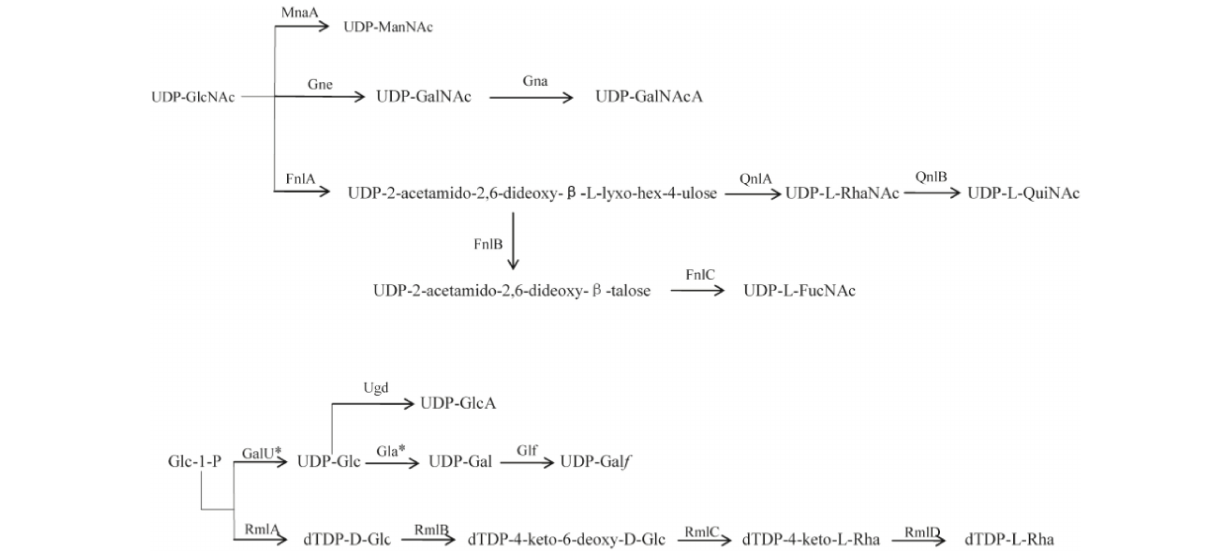
FIGURE 2 | Proposed biosynthesis pathways for sugars in the 12 P. shigelloides serogroups clusters. Putative pathways are denoted by a broken line. MnaA, UDP-N-acetylglucosamine-2-epimerase; Gne, UDP-N-acetylglucosamine-4-epimerase; Gna, UDP-GalNAcA synthetase; FnlA, 4,6-dehydratase, 3- and 5-epimerase; FnlB, reductase; FnlC, C-2 epimerase; QnlA, dTDP-4-dehydrorhamnose reductase; QnlB, C-2 epimerase; GalU ∗ , UTP-glucose-1-phosphate uridylyltransferase; Ugd, UDP-glucose 6-dehydrogenase; Gla ∗ , UDP-galacturonase; Glf, UDP-galactopyranose mutase; RmlA, glucose-1-phosphate thymidylyltransferase; RmlB, dTDP- D -glucose 4,6-dehydratase; RmlC, dTDP-4-keto-6-deoxy- D -glucose 3,5-epimerase; RmlD, dTDP-6-deoxy- L -mannose-dehydrogenase. D-GlcNAc, 2-acetamido-2-deoxy- D -glucose; D-ManNAc, 2-acetamido-2-deoxy- D -mannose; D-GalNAc, 2-acetamido-2-deoxy- D -galactose; D-GalNAcA, 2-Acetamido-2-deoxy- D -galacturonic acid; L-RhaNAc, 2-acetamido-2,6-dideoxy- L -mannose (N-acetyl-L-rhamnosamine); L-QuiNAc, 2-Acetamido-2-deoxy- L -quinovose (2-acetamido-2,6-dideoxy- L -glucose); L-FucNAc, 2-Acetamido-2-deoxy- L